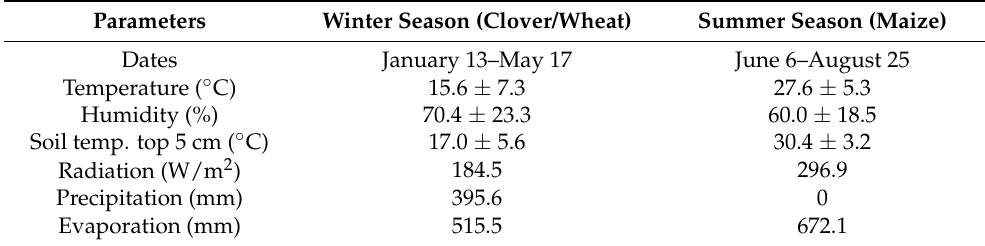
Table 2. Meteorological data for the 2021 dual season experiment 1